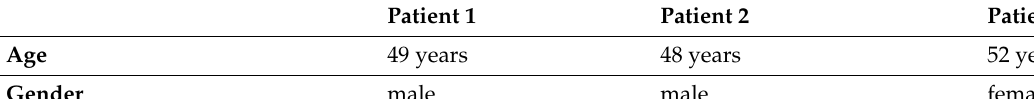
Table 1. Characteristics of surgical